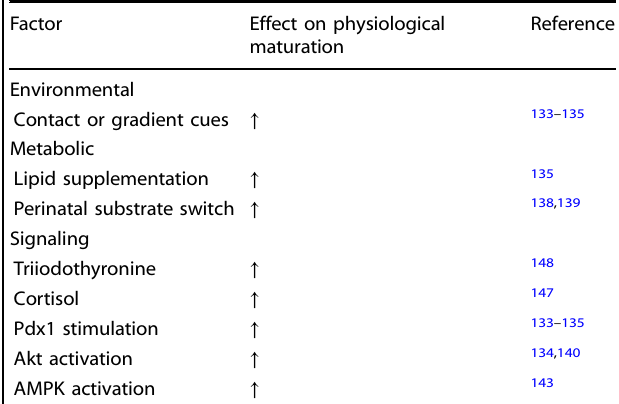
Table 4. Factors in fl uencing pancreatic tissue